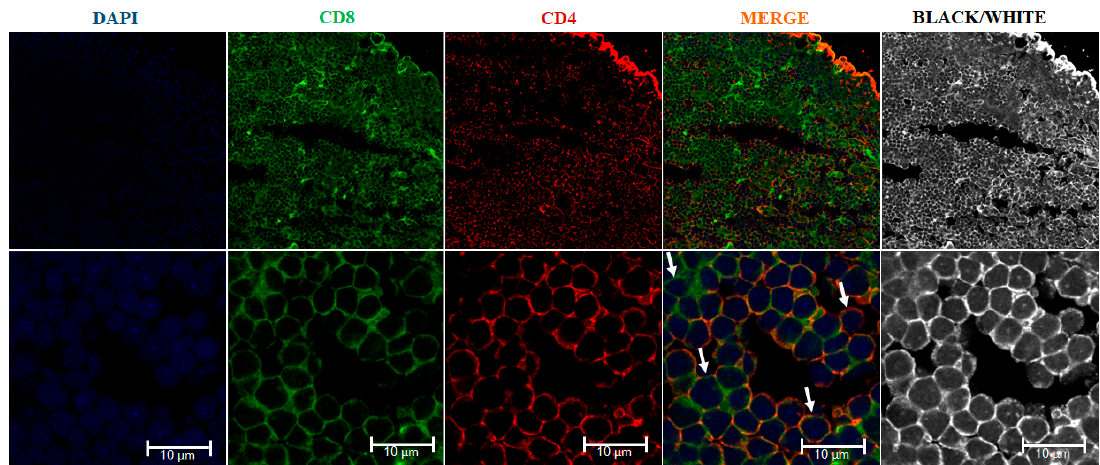
Figure 3 . Immunofluorescence of the rainbow trout ( Oncorhynchus mykiss ) thymus. The thymic slices were incubated with rabbit affinity-purified anti-trout CD4-1 antibody (red) and rat monoclonal anti-trout CD8 alpha (green). Nuclei were stained with DAPI (blue). A CD4/CD8 double negative cell is indicated with left upper arrow, a CD8 cell single positive is indicated with the lower left arrow, a CD4/CD8 double positive cell is indicated with lower right arrow, and a CD4 single positive cell is indicated with the upper right arrow. Samples were examined under a Leica TCS SP8 laser scanning fluorescence confocal microscope.